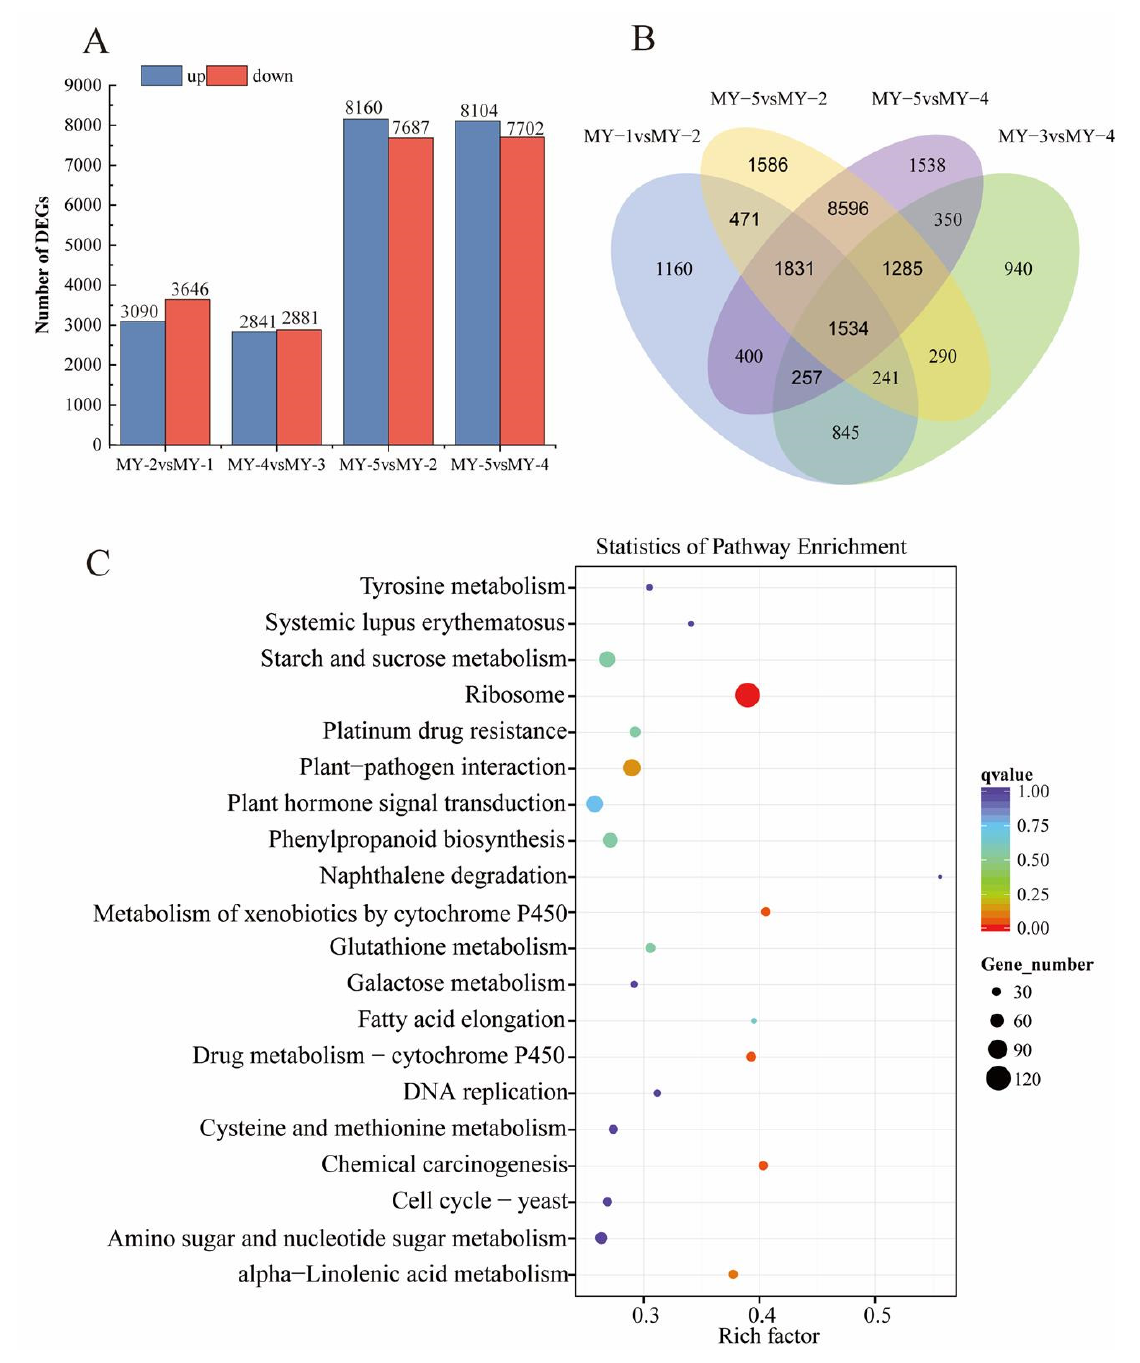
Figure 7 . RNA-Seq analysis of R. delavayi . ( A ) Histograms of DEGs obtained by comparison of four pairs of samples, namely, MY-1 vs MY-2, MY-3 vs MY-4, MY-5 vs MY-2, and MY-5 vs MY-4, respectively. ( B ) Venn diagram of DEGs in the four combinations. ( C ). KEGG enrichment analysis of MY-1 vs MY-2 DEGs.